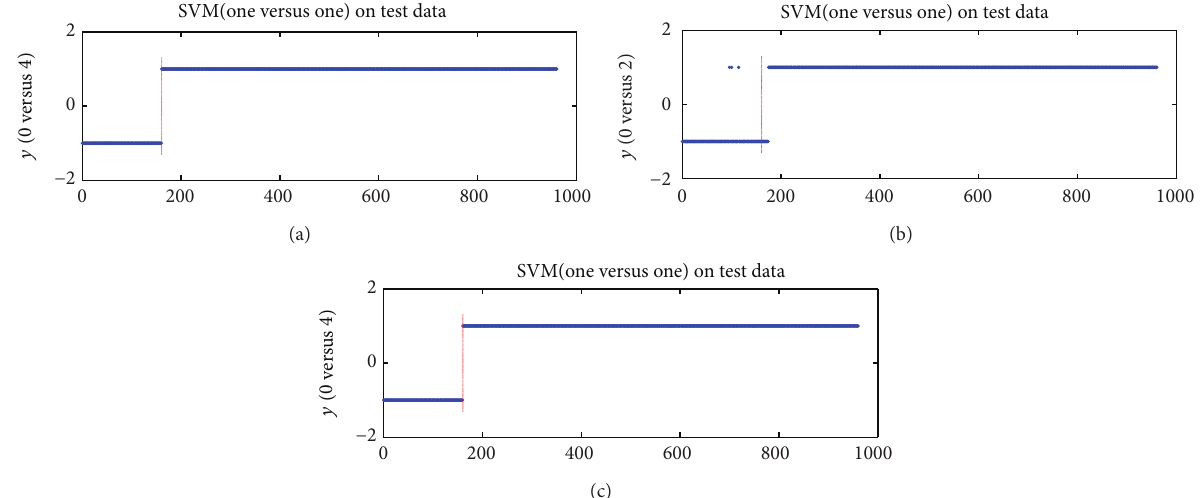
Figure 2: Classification results for the testing dataset by the SVM-based classifier with optimal parameters. The value 𝑦 = −1 represents at the sample-taken moment that the process is in normal condition, while 𝑦 = 1 stands for faulty condition. The top plot is the classification result between normal condition and fault 1, the middle one is the result between normal condition and fault 2, and the last plot is result between normal condition and fault 4. In the simulation of fault condition, the fault information appears from the moment of 161th sample-taken and it is pointed out by red line.